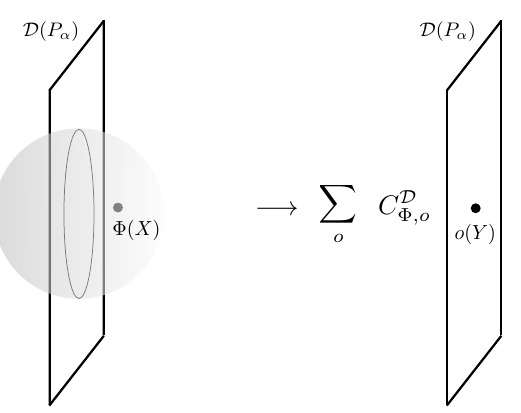
Figure 3 . A spherical slice enclosing the bulk operator (cid:8)( X ) and cutting a 2-dimensional defect D ( P (cid:11) ). The state induces on the slice can be expanded in terms of defect local operators o ( Y ).